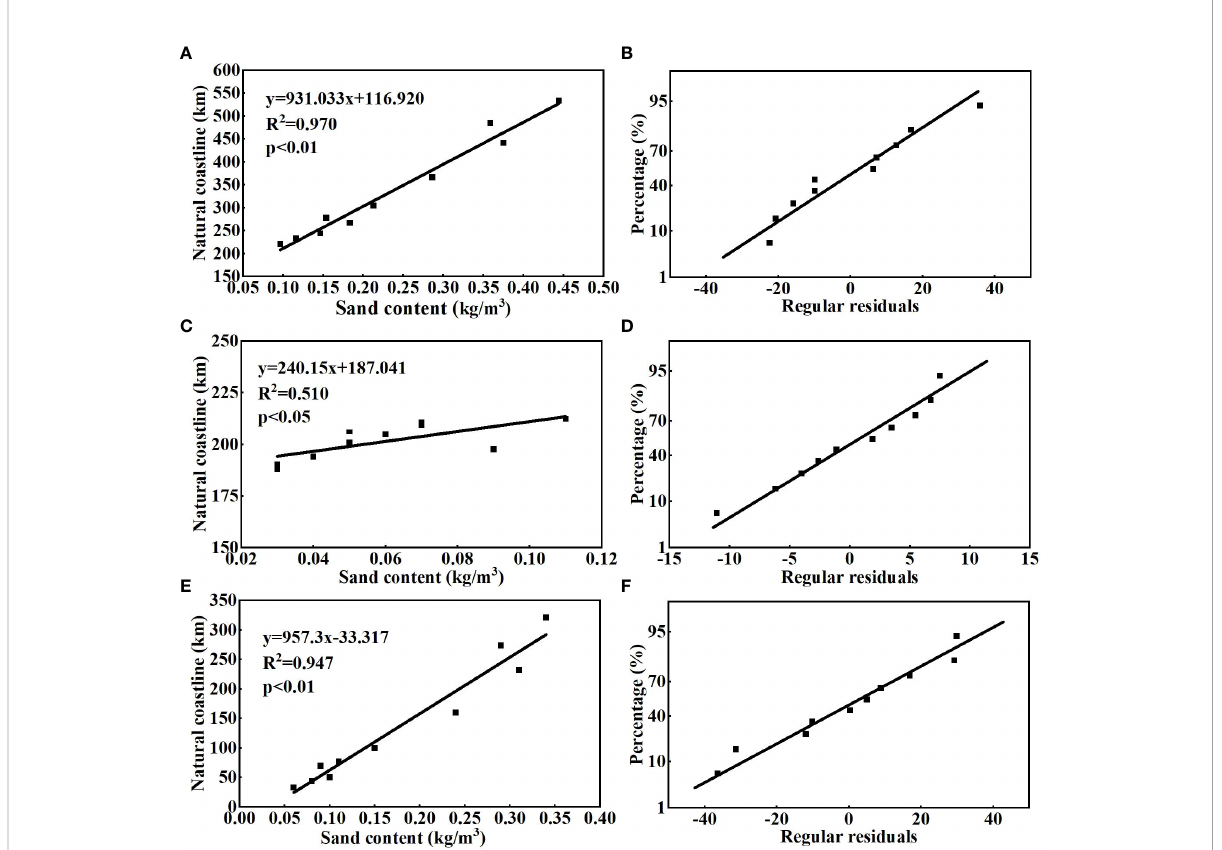
FIGURE 10 The relationship between natural coastline variations and dominant driving factors based on multivariate stepwise linear regression analysis: (A) the whole Pearl River Estuary (PRE), (C) East coast in the PRE, (E) West coast in the PRE; and the residual plots for regression analysis: (B) the whole Pearl River Estuary (PRE), (D) East coast in the PRE, (F) West coast in the PRE (R 2 represents determination coef fi cient and p represents signi fi cance